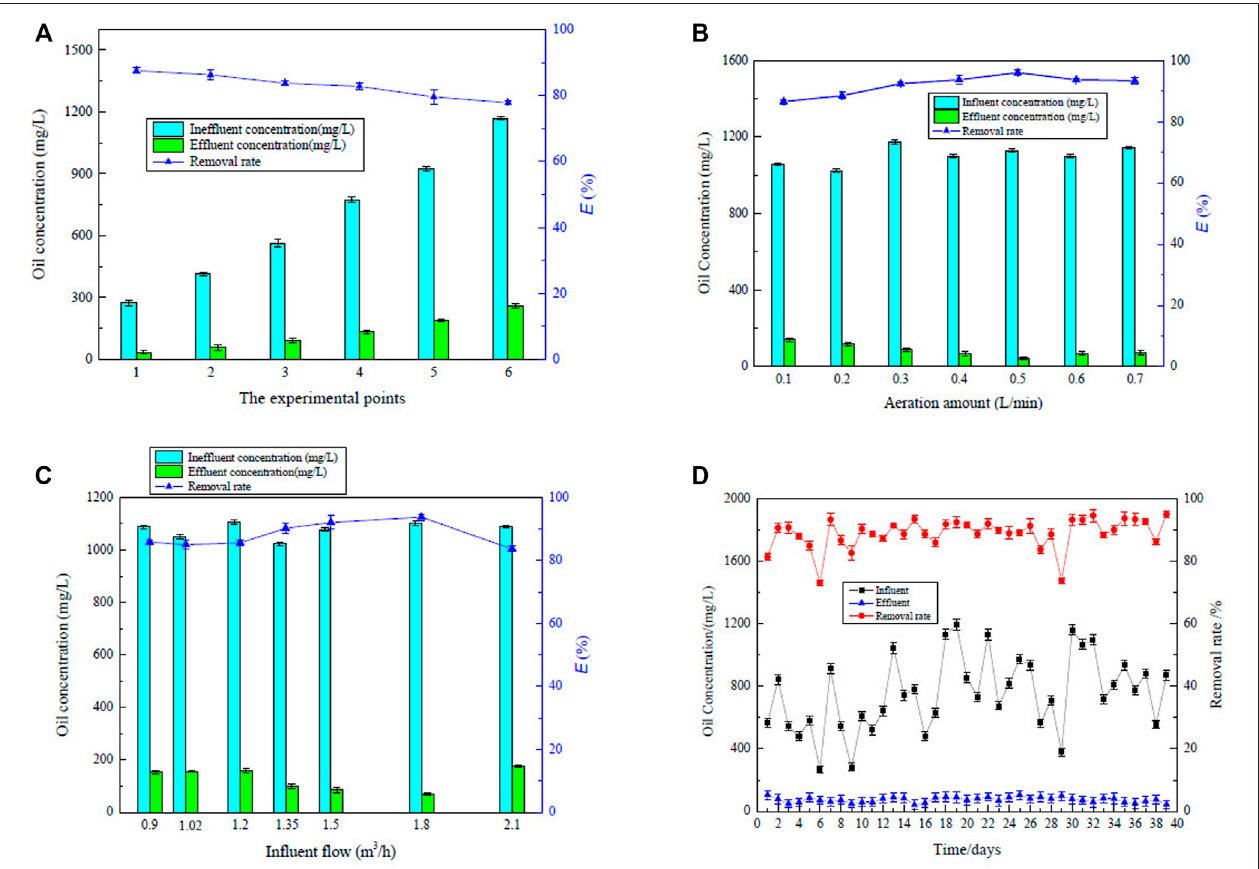
FIGURE2| Changeintheremoval ratewithdifferentconditions (A) differentinitialoilconcentrations; (B) differentaeration rates; (C) differentin fl uent fl ows;and (D) continuous running experiment.